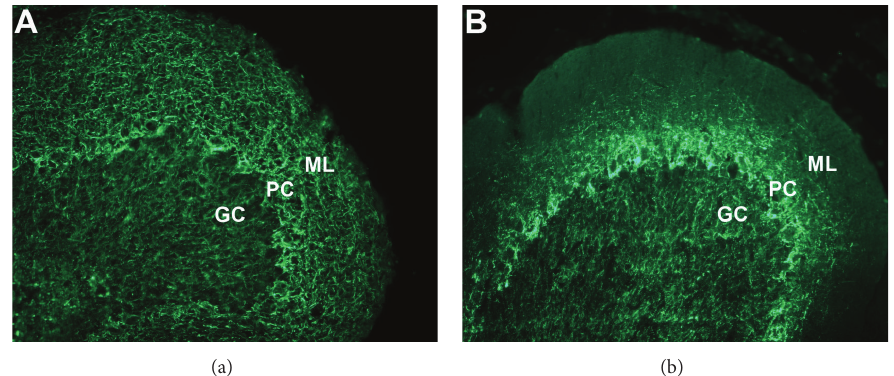
Figure 1: Low-power (20x objective) photomicrographs of SMI-31 axonal staining in lobule III from sham cerebellum (a) and the cerebellum from a 42-day SCI animal (b). Note the prominent decrease of SMI-31 positive immunoreactive profiles in the molecular layer (ML) corresponding to a loss of granule cell parallel fibers. PC: Purkinje cell layer; GC: granule cell region.